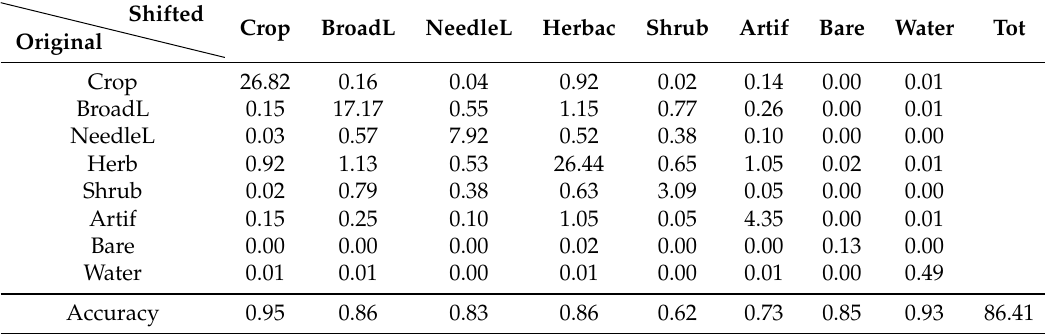
Table 5. Example of confusion matrix for a 1.5 pixel shift along the diagonal of the X,Y axes.